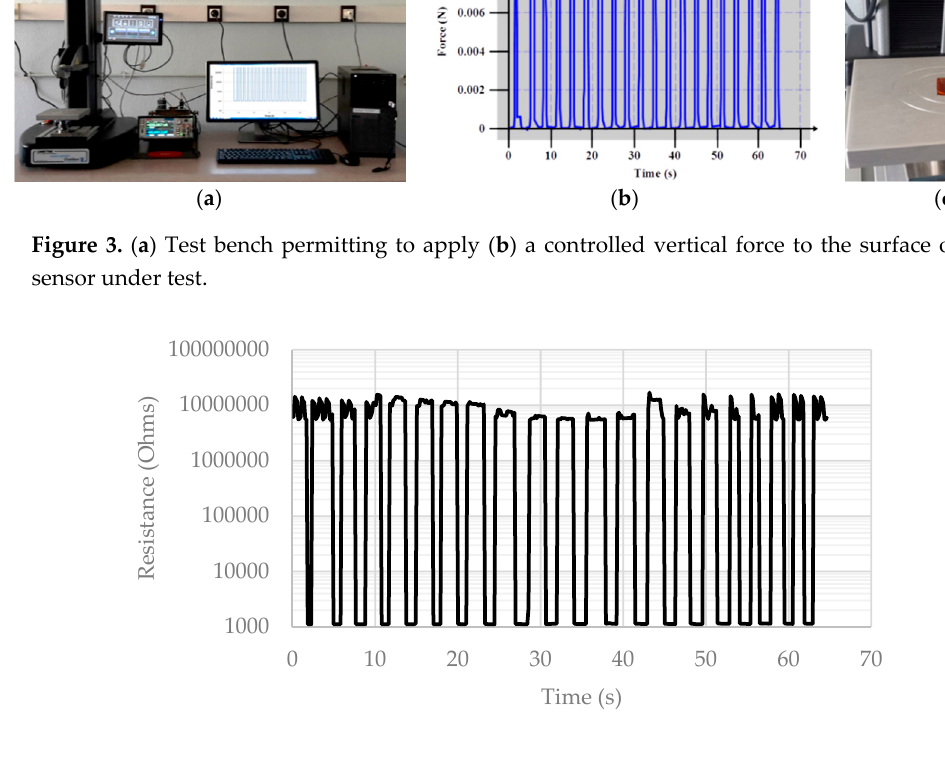
Figure 4. Electrical characterization of the inkjet-printed ON/OFF force sensor when the force described on Figure 3 is applied vertically to its